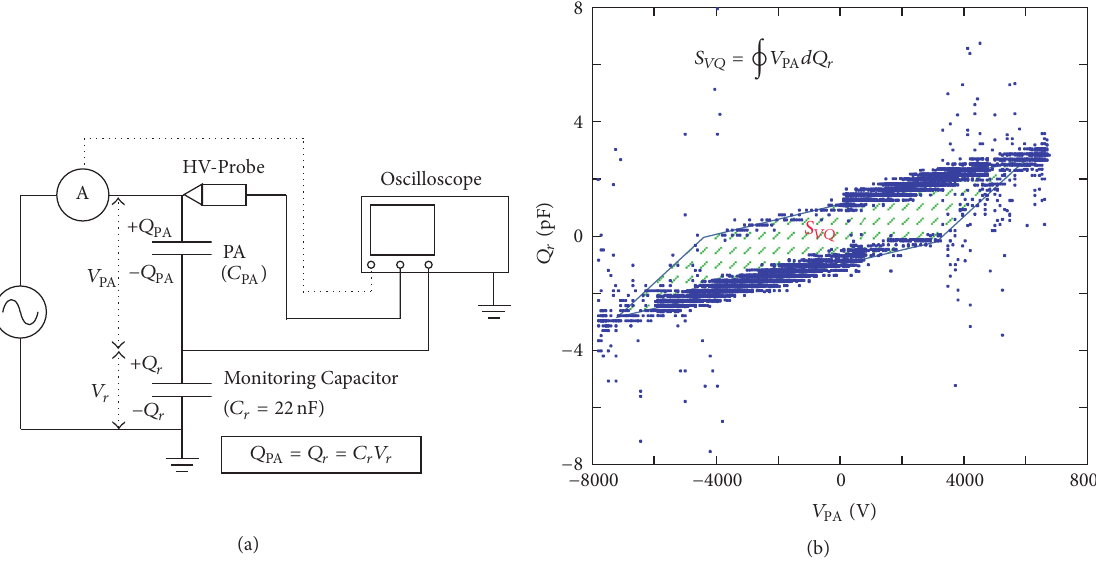
Figure 5: Power consumption evaluation ( 𝑃 PA ) of string-type DBD plasma actuator by means of 𝑉 - 𝑄 Lissajous method. (a) Electric circuit = 12.0 kV at frequency 𝑓 𝑝 = 9 kHz. 𝑃 PA is calculated as the product of 𝑓 𝑝 × 𝑆 𝑉𝑄 . diagram; (b) 𝑉 - 𝑄 Lissajous figure by applying 𝑉 𝑝 - 𝑝